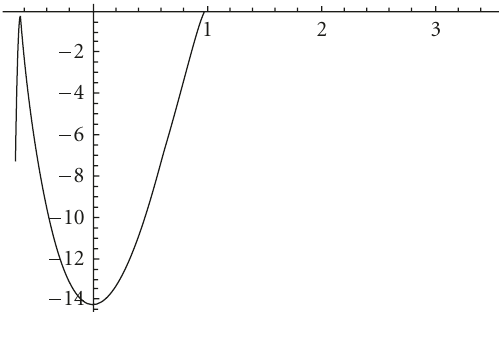
Figure 4.1. ( ρ 0 (cid:8) 0 . 999112, ξ (cid:8) − 0 .